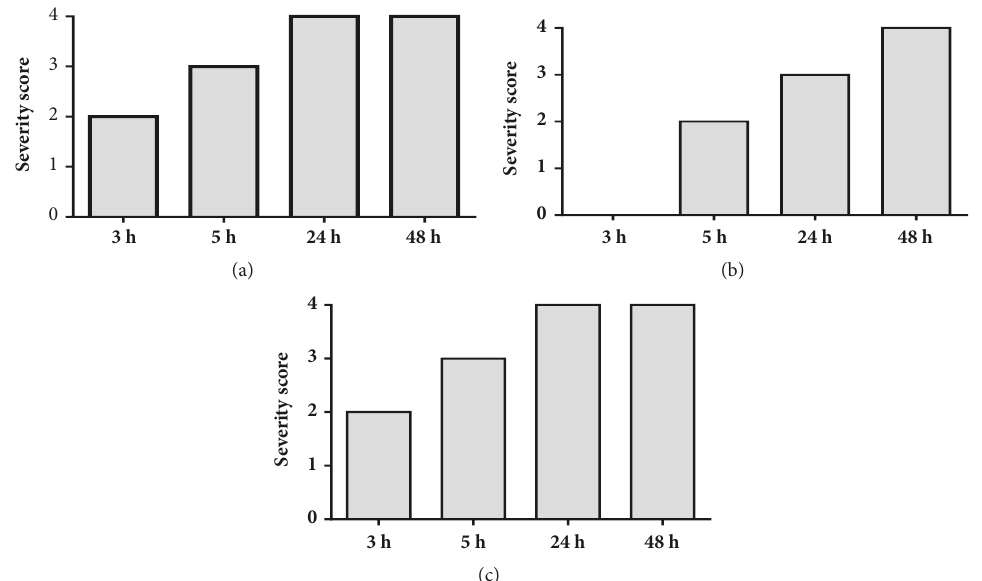
Figure 5: Adult S. mansoni severity scores after exposure to 1.25 𝜇 g/mL of fractions derived from the methanol bark extract of E. ivorense .